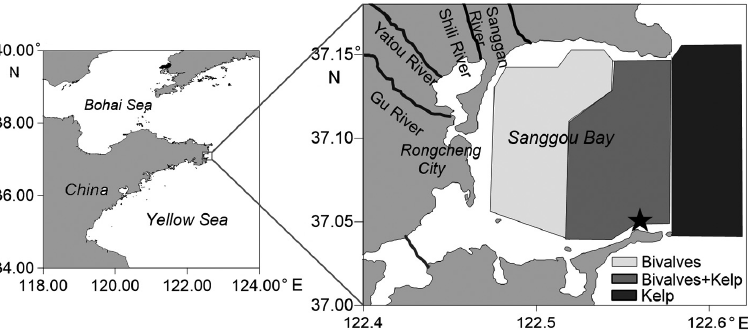
Fig. 1. Sanggou Bay, China, showing the culture areas and the incubation experiment site ( ★ )